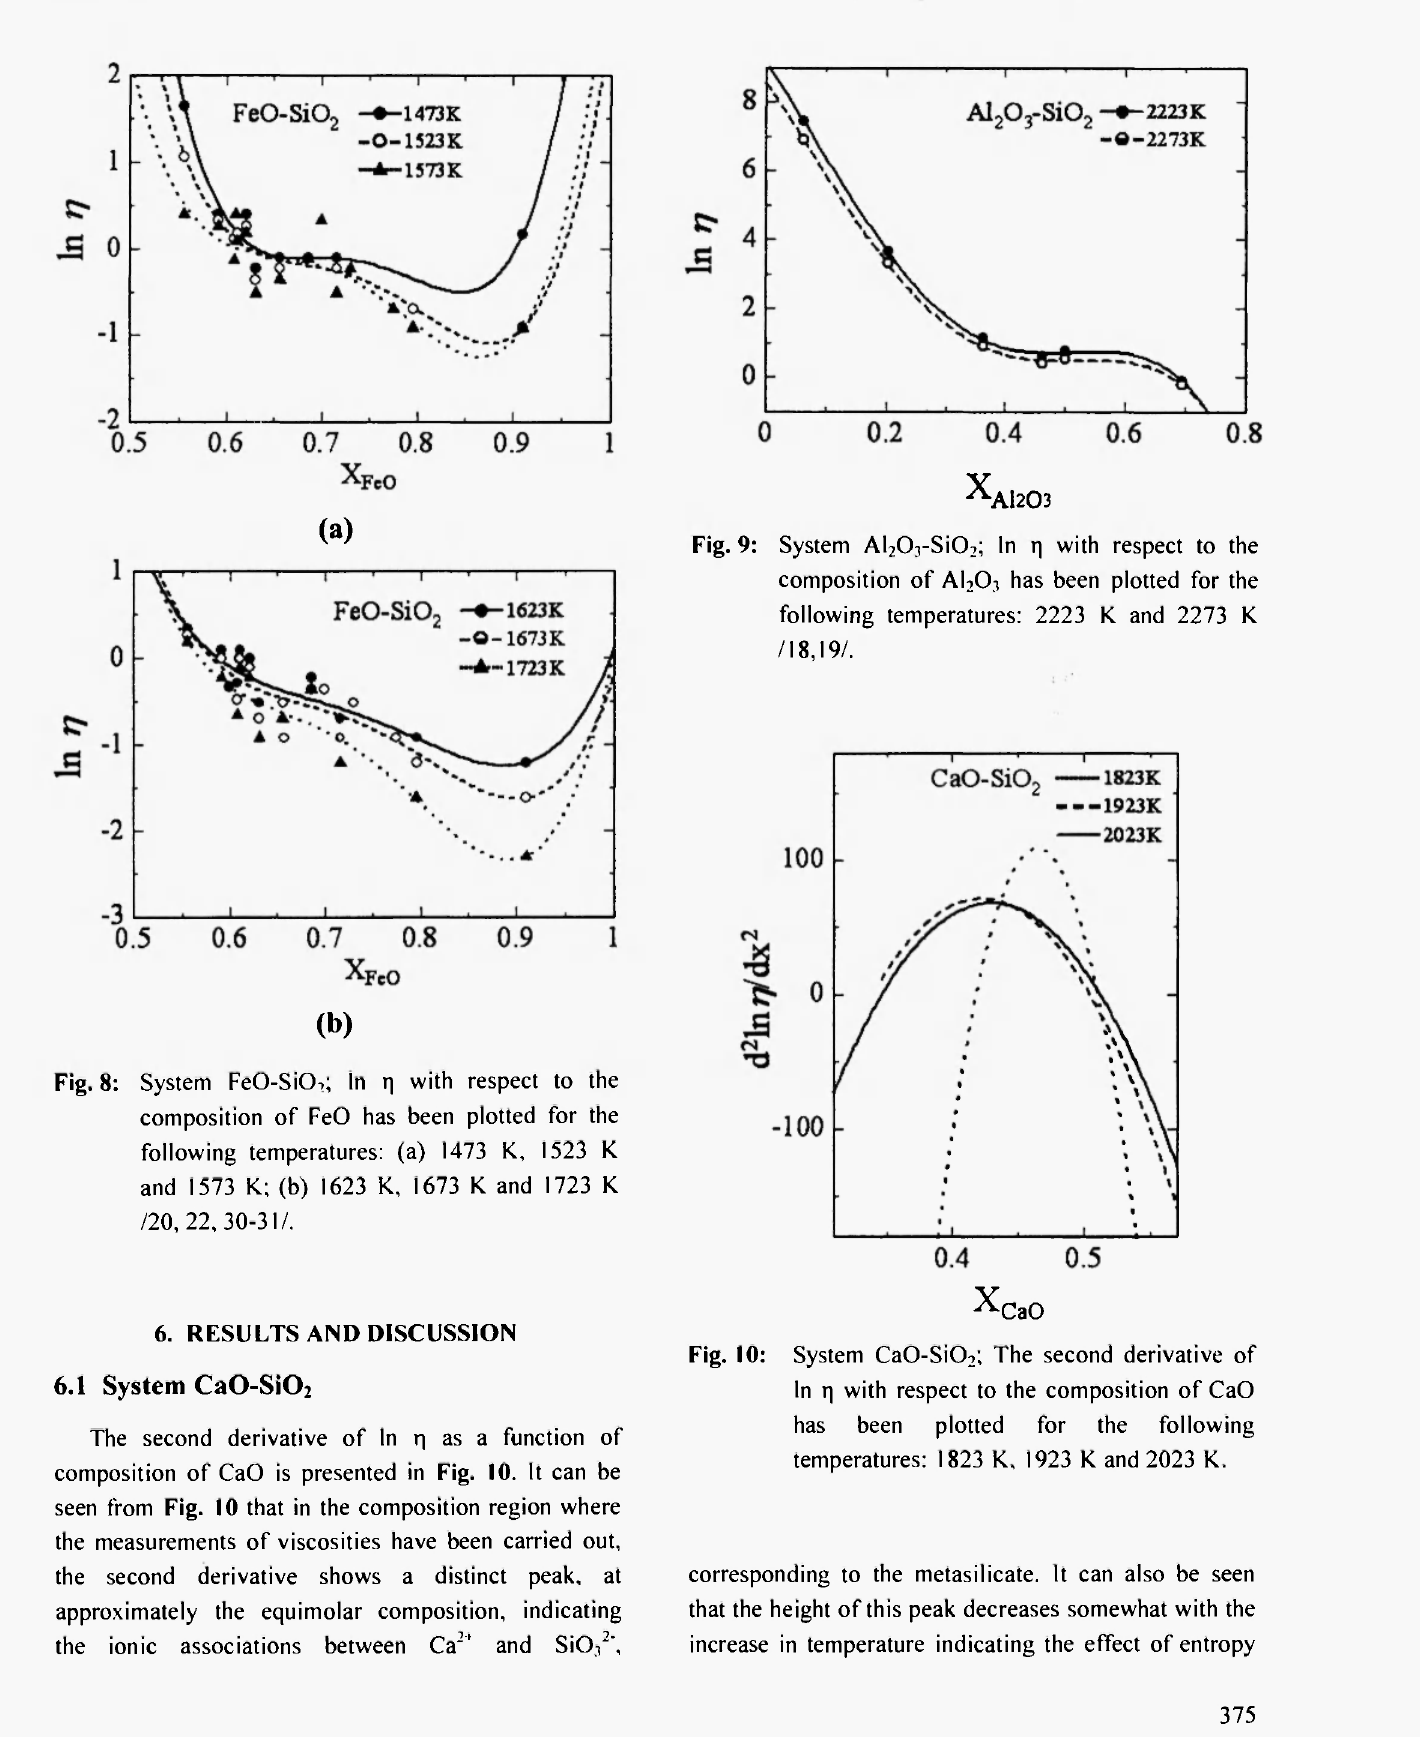
Fig. 9: System A I 2 0 r S i 0 2 ; In η with respect to the composition of Al 2 0 3 has been plotted for the following temperatures: 2223 Κ and 2273 Κ /18,19/.